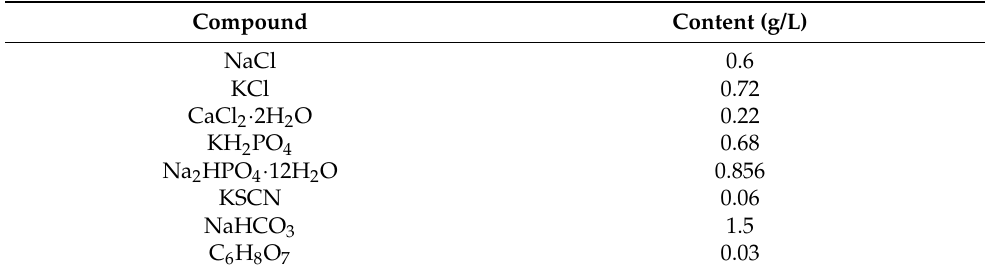
Table 2. Composition of artificial saliva (pH =